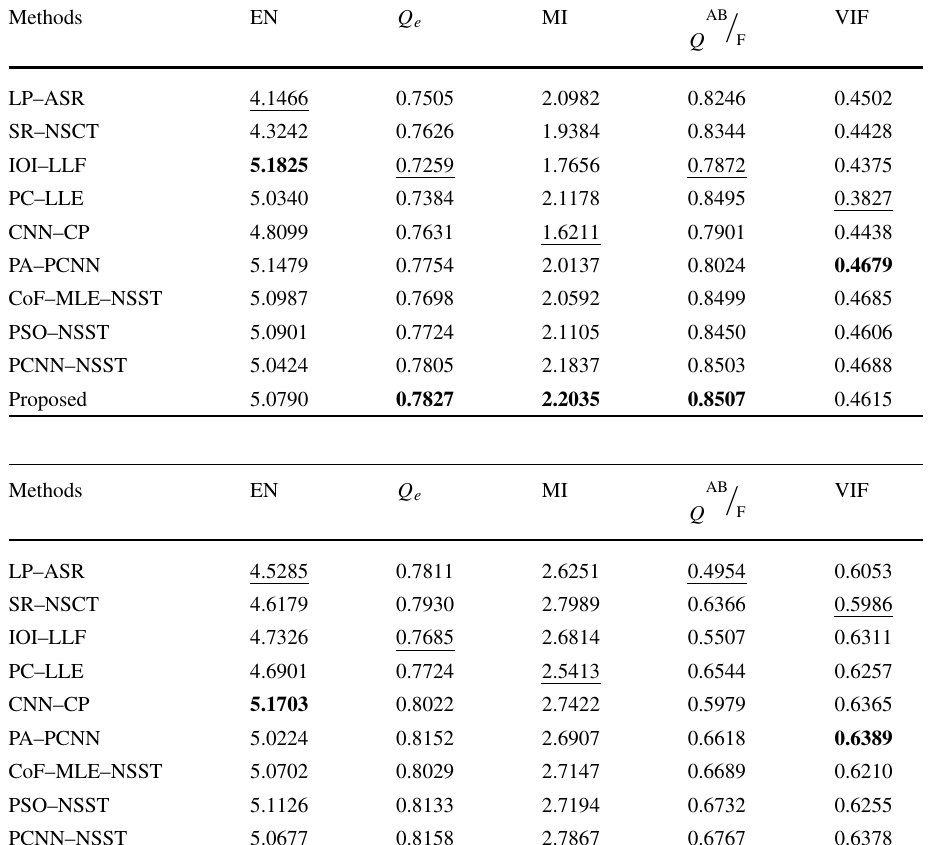
Table 2 Objective evaluation of MRI–SPECT fusion images